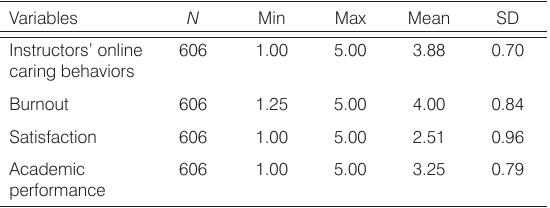
Table 2. Descriptive statistics of the key study variables.